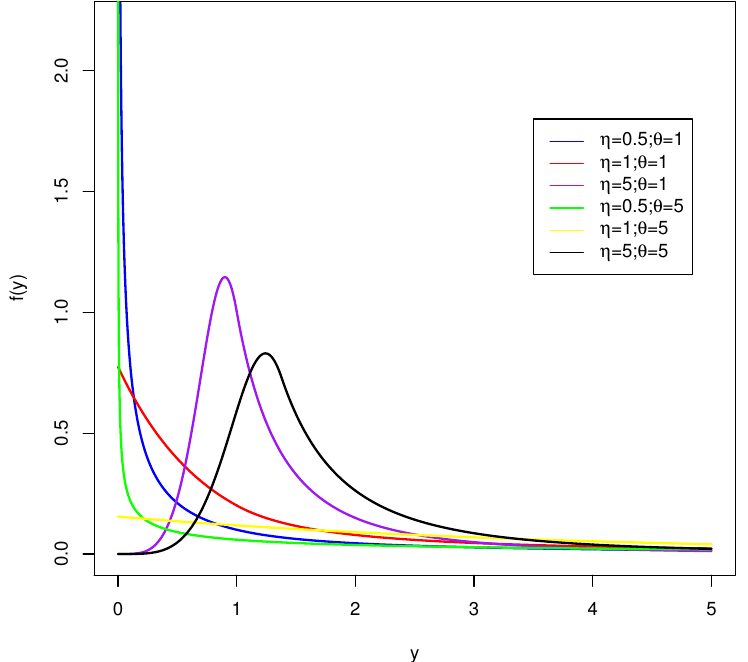
Figure 2. Plots of the exponentiated exp-Pareto density function, for some parameter